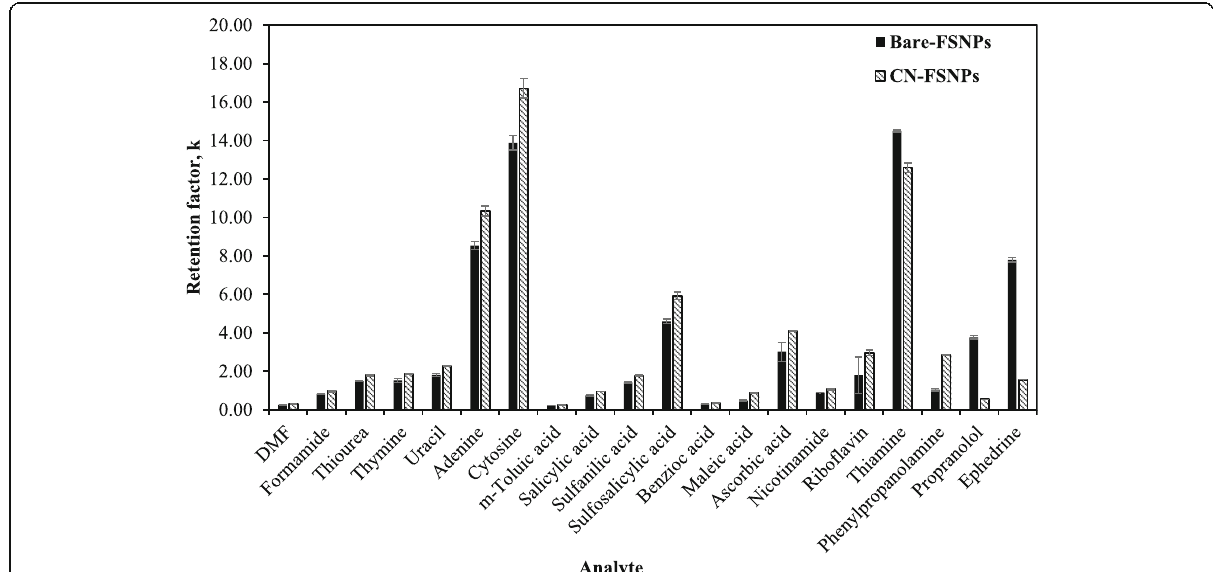
Fig. 9 Comparison of the k values obtained on FSNPs-poly(GMM-co-EDMA) column to those obtained on the CN-FSNPs-poly(GMM-co-EDMA) column under the same experimental